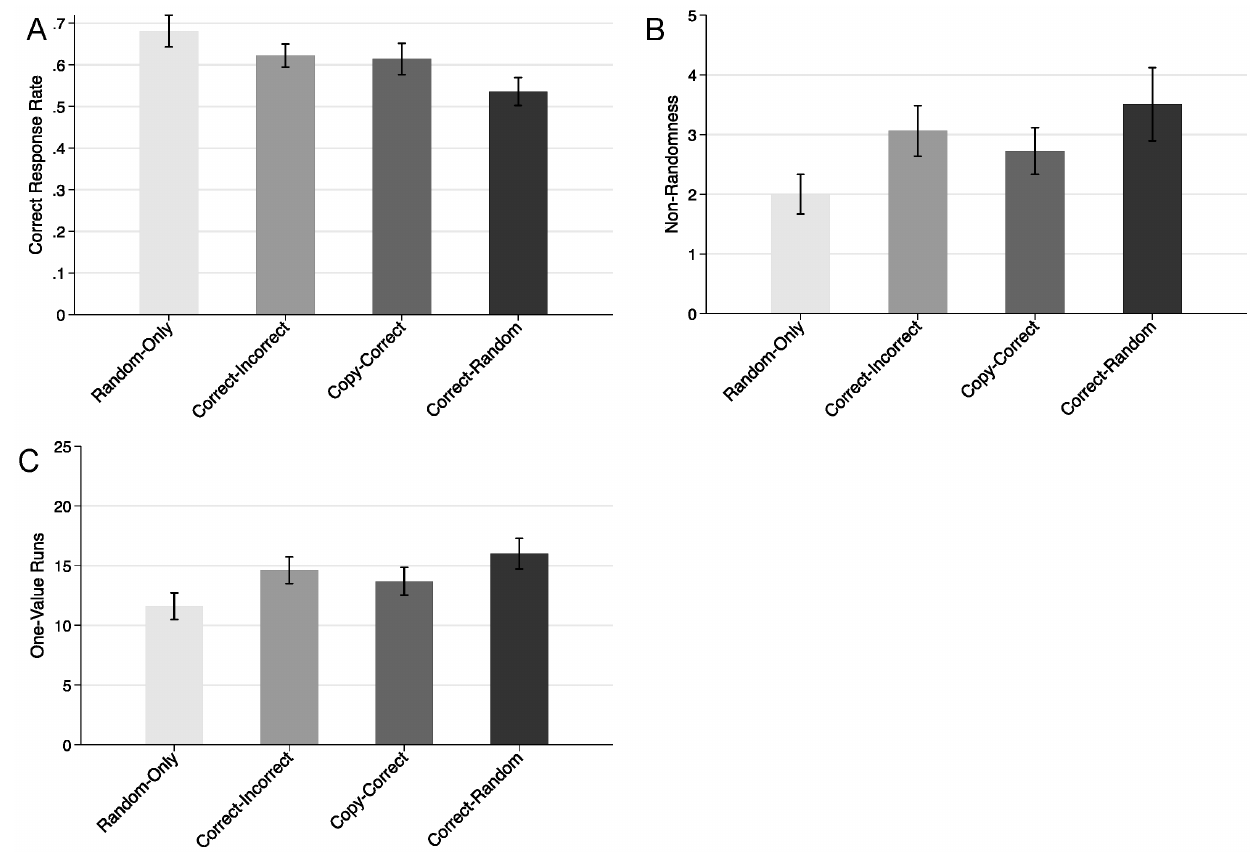
Figure 3. Means for (A) correct response rate, (B) non-randomness, and (C) one-value runs by experimental condition (Experiment 2). Error bars are standard errors of the means.